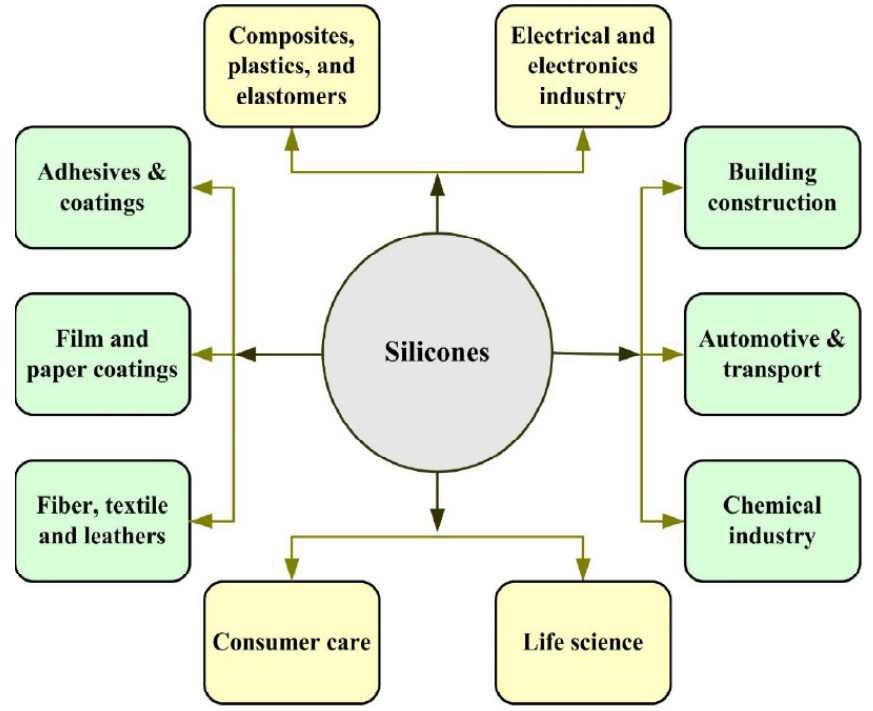
Fig. 1. Silicones